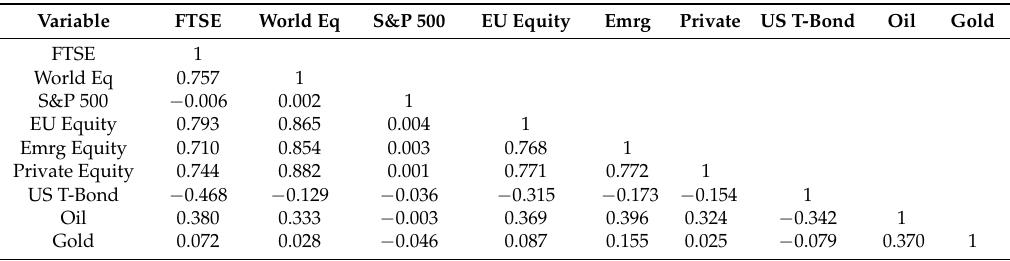
Table 3. Correlation Matrix of Log